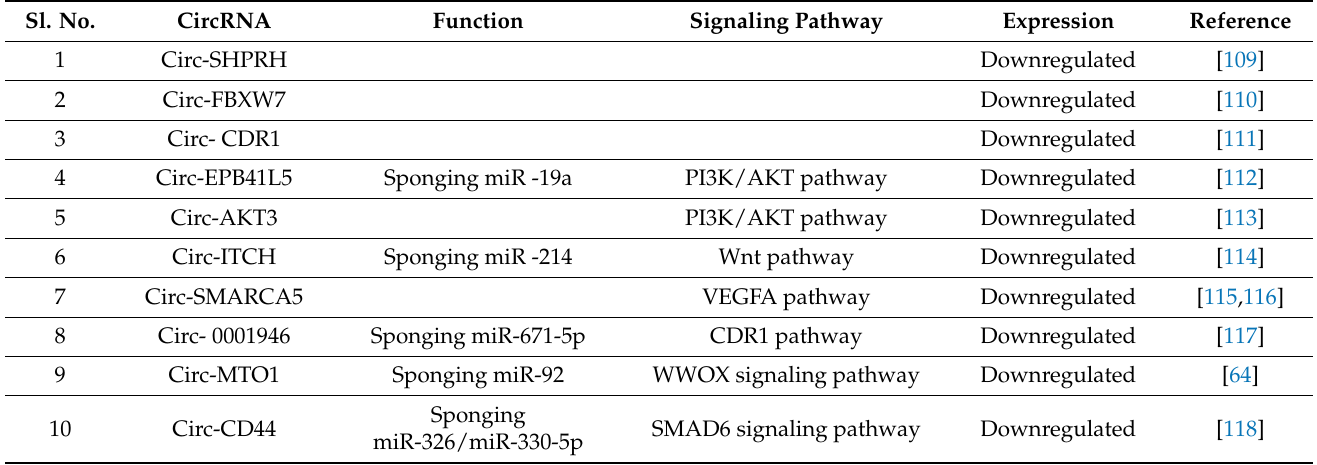
Table 3. List of circRNAs responsible for the down-regulation of glioblastoma. Function Signaling Pathway Expression